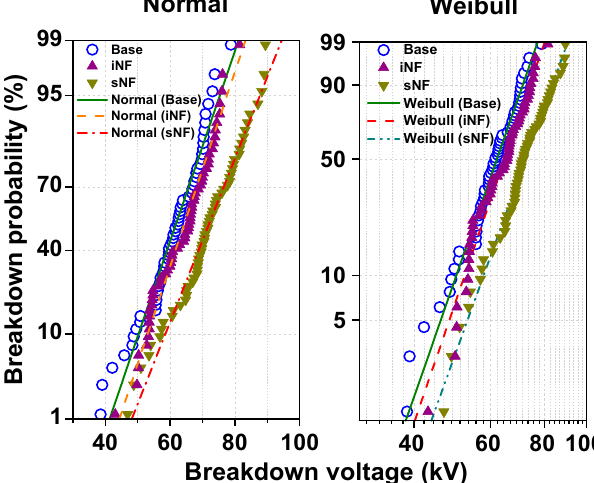
Figure 6. Frequency density plots of the breakdown events for each sample in question with conformity to Normal distribution.